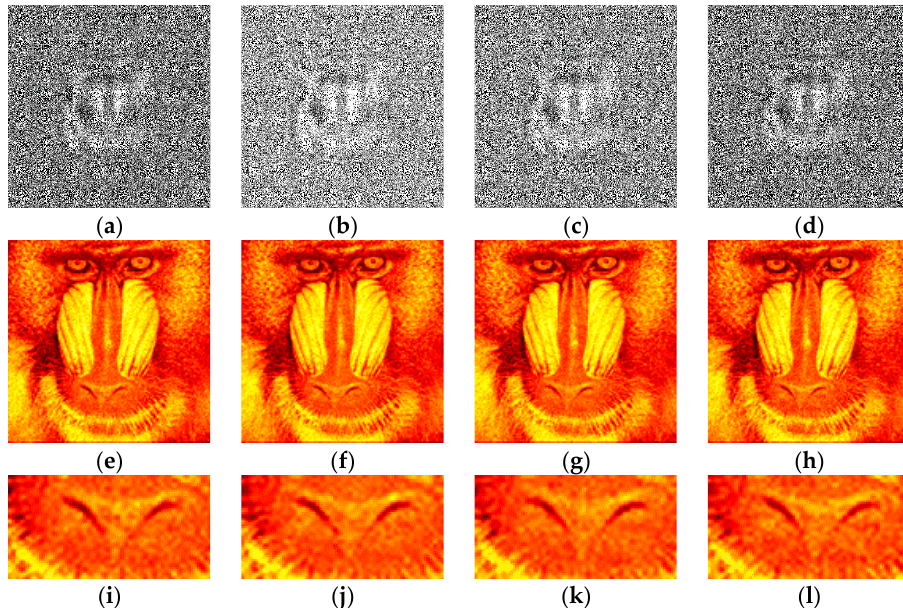
Figure 9. Examples of synthesized binary inline Fresnel holograms containing the “Baboon” image after application of DSRT technique, corresponding reconstructed images and their enlarged fragments. Holograms were binarized using the Otsu ( a , e , i ), Sauvola ( b , f , j ), Li ( c , g , k ), and Huang ( d , h , l ) methods.